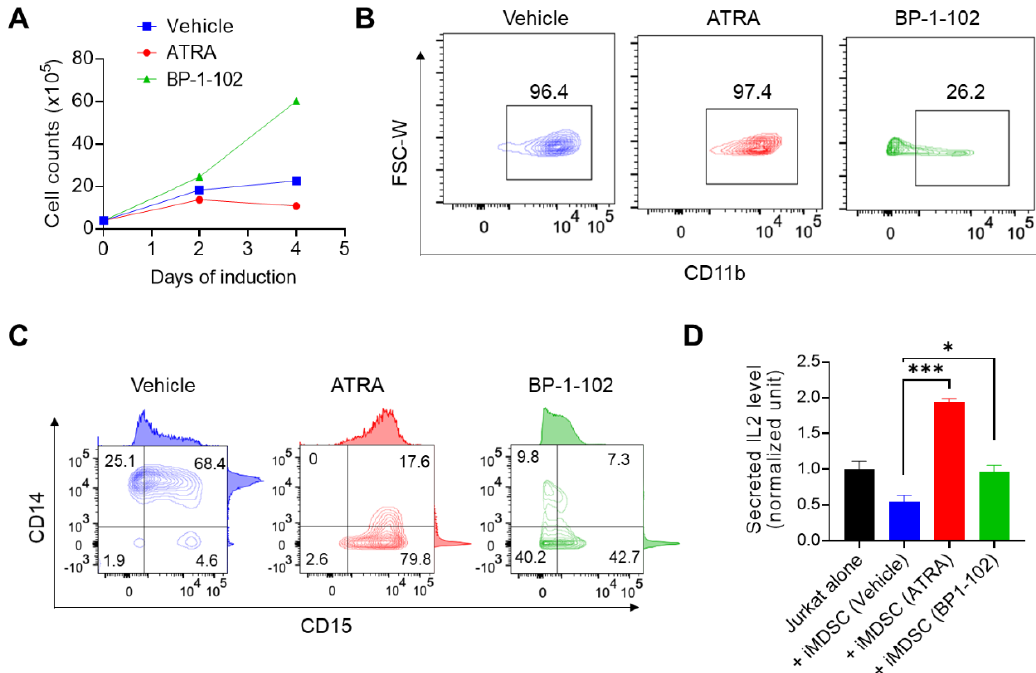
Figure 5. All-trans retinoic acid (ATRA) and STAT3 inhibitor BP-1-102 direct iMDSC to distinct non-suppressive states. ( A ) Proliferation curves of iMDSC cells treated with vehicle, ATRA and BP-1-102 throughout the 4-day induction course. ( B , C ) Flow cytometry analysis of CD11b, CD14 and CD15 expression on iMDSC treated with vehicle, ATRA and BP-1-102 at the end of the 4-day induction course. ( D ) Relative IL2 level (measured by ELISA) in the medium from stimulated Jurkat alone or co-cultured with iMDSC pre-treated with vehicle, ATRA and BP-1-102. * p < 0.05, *** p < 0.001, two-tailed Student’s t -test. For ( D ), one-way ANOVA followed by multiple comparisons returned equivalent significance levels.